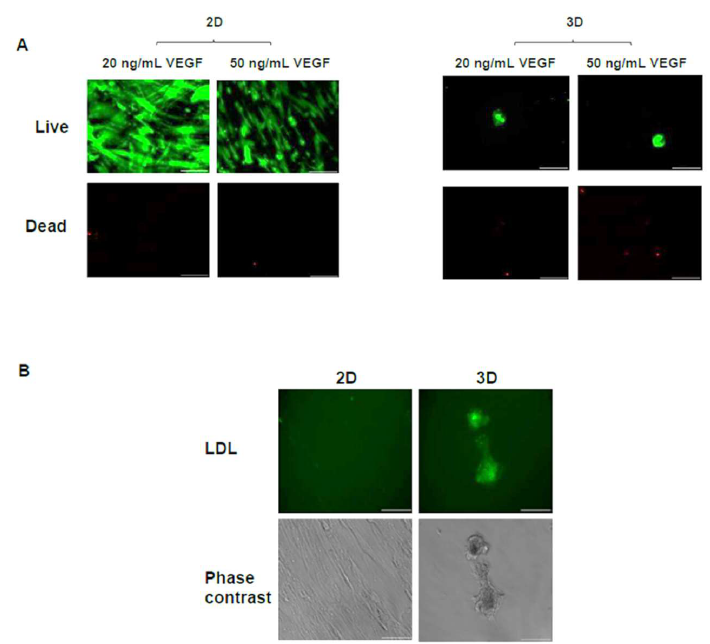
Figure 5. ( A ) Live/dead images of hASCs cultured in the scaffold-free 2D and 3D conditions on day 7. Conditions also indicate the amount of VEGF added to the culture media. Scale bars = 100 μm. ( B ) Uptake of acetylated LDL (green) and phase contrast images in the scaffold-free 2D and 3D conditions given 20 ng/mL of VEGF for 7 days. Scale bars = 100 μm.